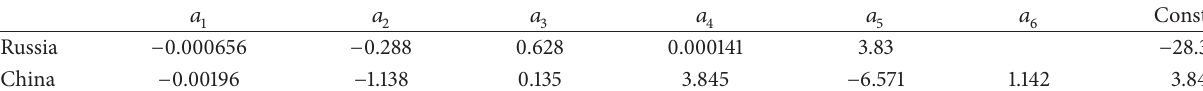
Table 3: Parameter estimation results.